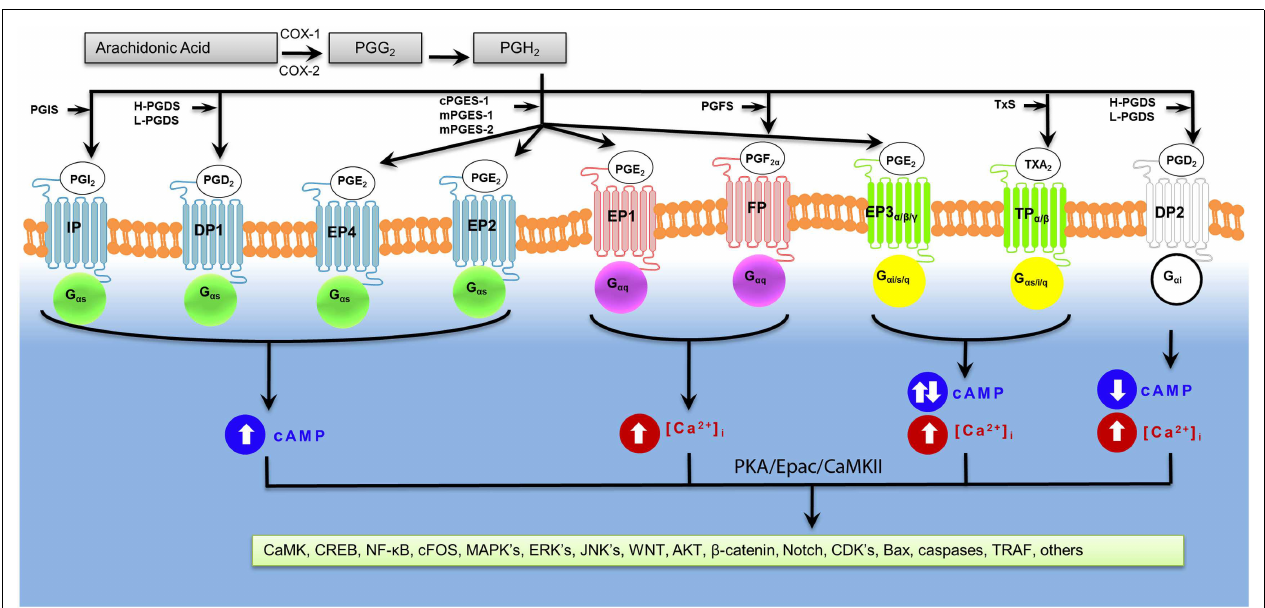
FIGURE 2 | Signal transduction mechanisms of activated prostaglandin receptors. Prostaglandin receptors have been grouped into specific G-protein-dependent cAMP and/or Ca 2 +